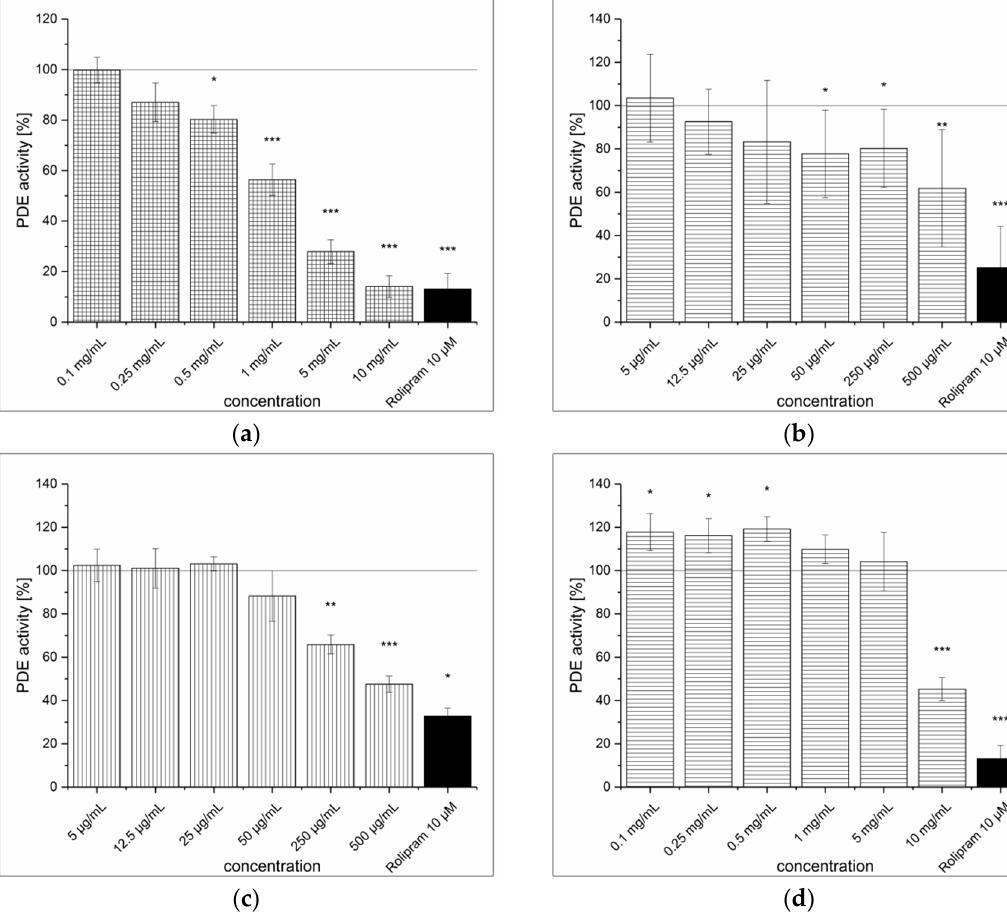
Figure 5. cAMP-specific phosphodiesterase (PDE) activity following incubation with ginger powder extract (GPE) ( a ), [6]-gingerol ( b ), ginger lipoid fraction (GLE) ( c ) and ginger hydrophilic fraction (GWE) ( d ). Data are presented as the mean ± standard deviation of three independent experiments. The significance of differences between sample and control was assessed with a Student’s t -test. Confidence intervals: * p < 0.05; ** p < 0.01; *** p < 0.001.